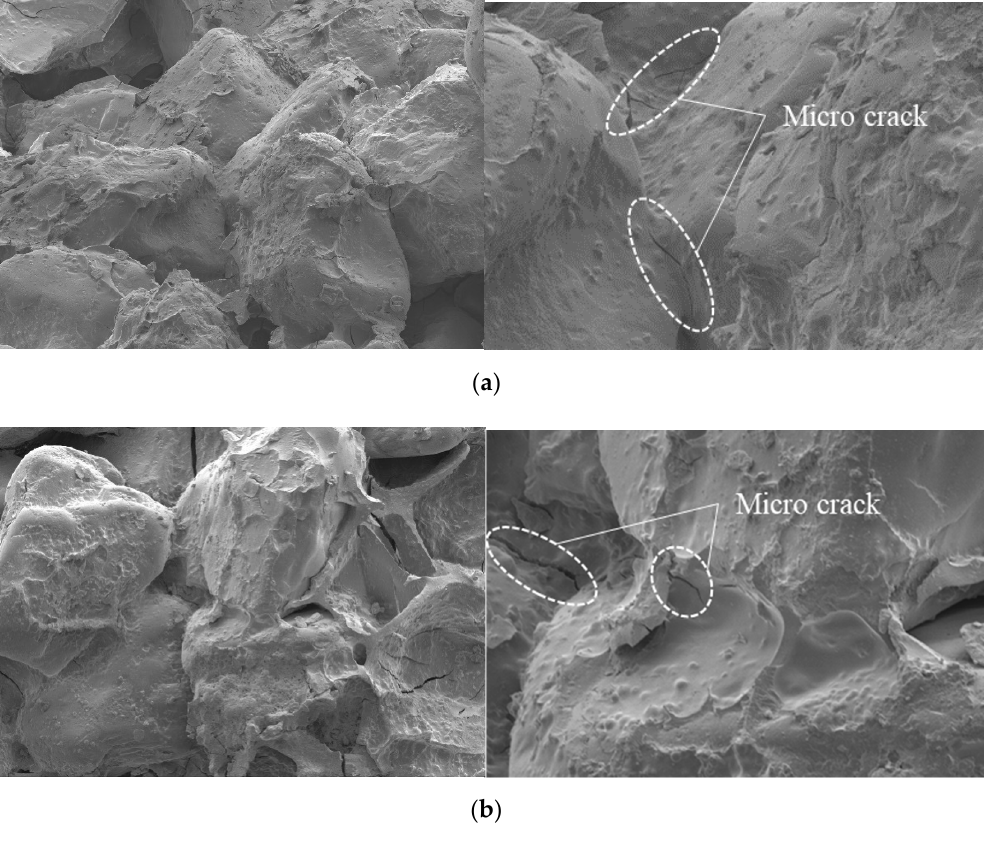
Figure 7. Results of SEM image analysis (Left: x 100 , Right: x 4 00). ( a ) Scanning electron microscope (SEM) images of STD samples , ( b ) SEM images of MOD samples , ( c ) SEM images of MBS samples.